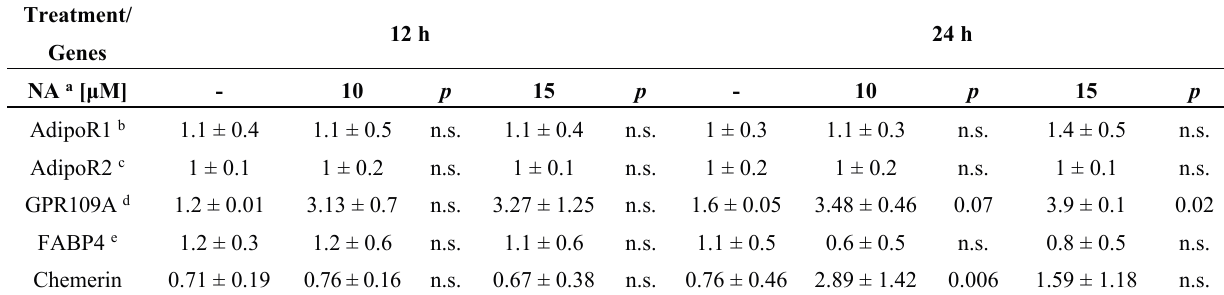
Table 1. Niacin effects on the mRNA abundance of selected